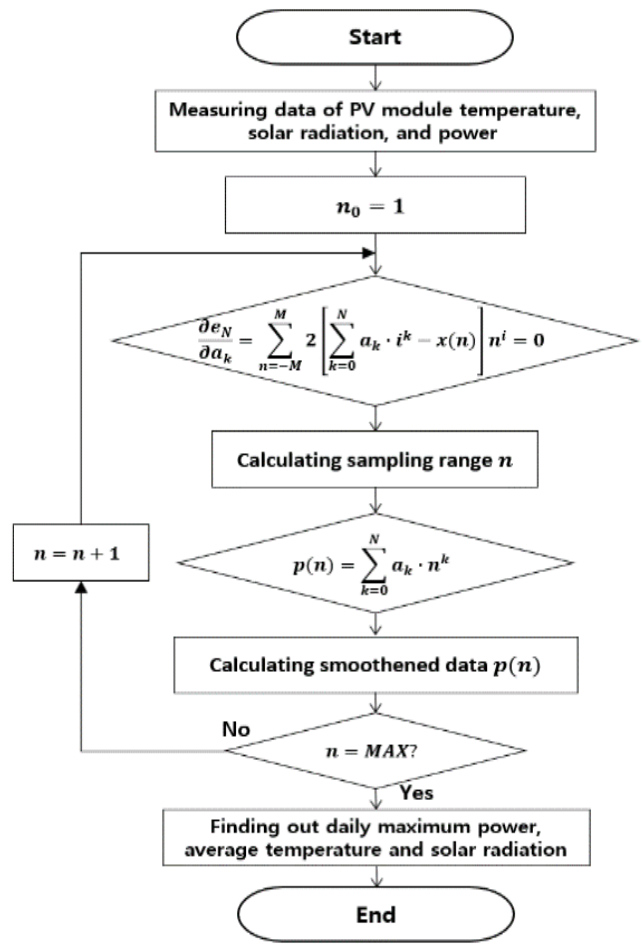
Figure 4. Procedure of the degradation analysis modeling.